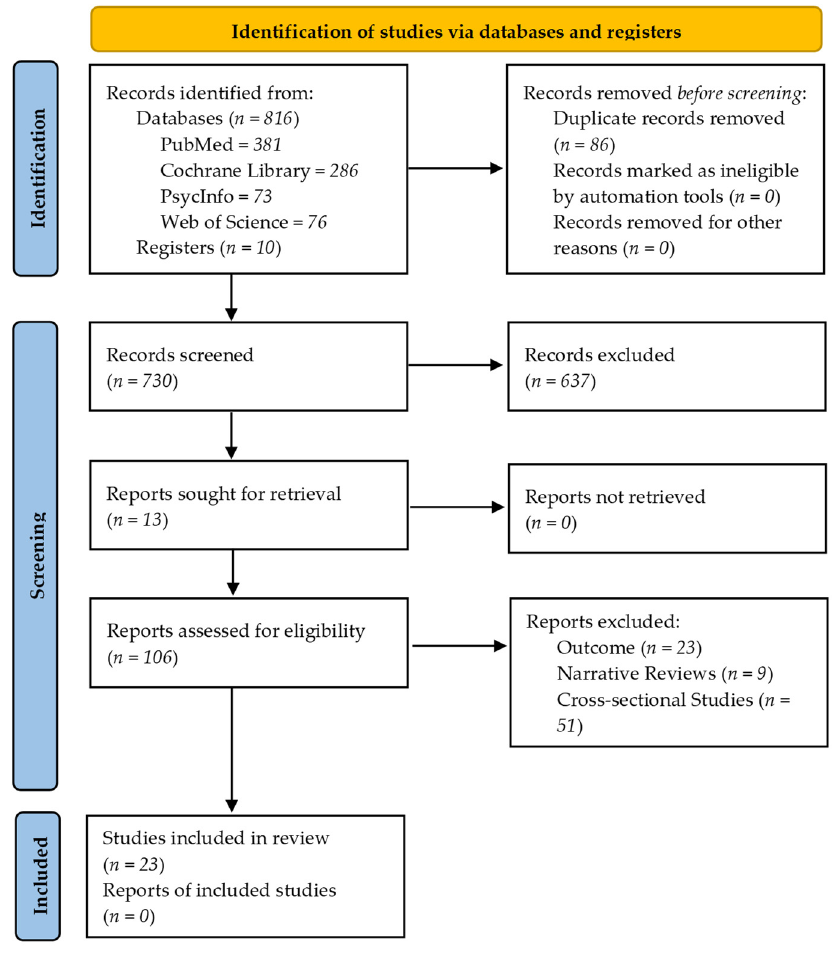
Figure 1. PRISMA flow diagram of the included and excluded studies throughout the systematic review protocol.